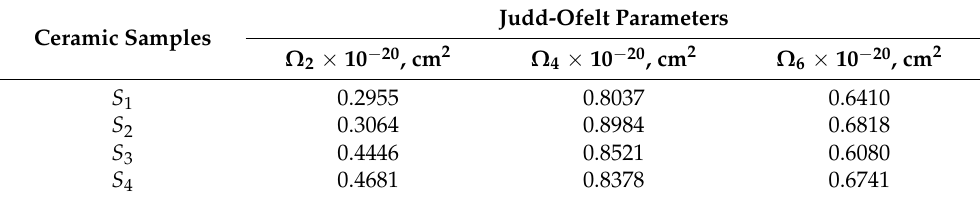
Table 4. Judd–Ofelt parameters of the Er 3+ -doped YAG (YSAG) ceramics at 300 K. Ceramic Samples